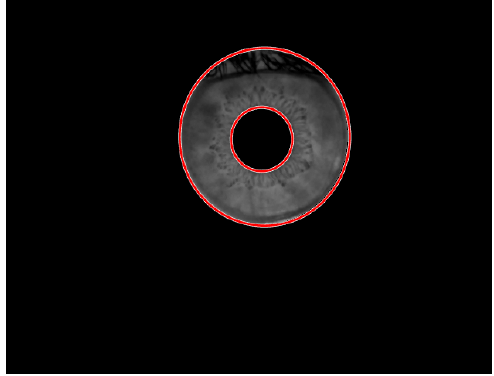
Figure 6. Output of segmentation.